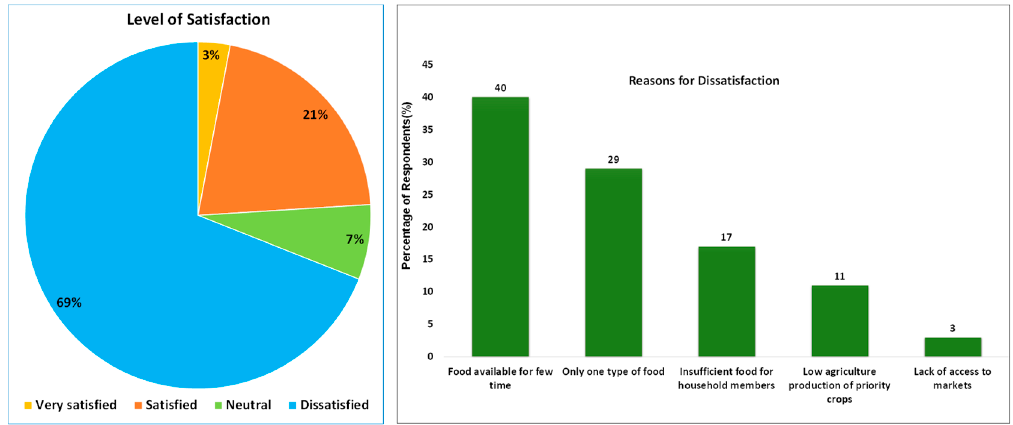
Figure 7. Level of farmers’ satisfaction about LUC and reasons behind it.